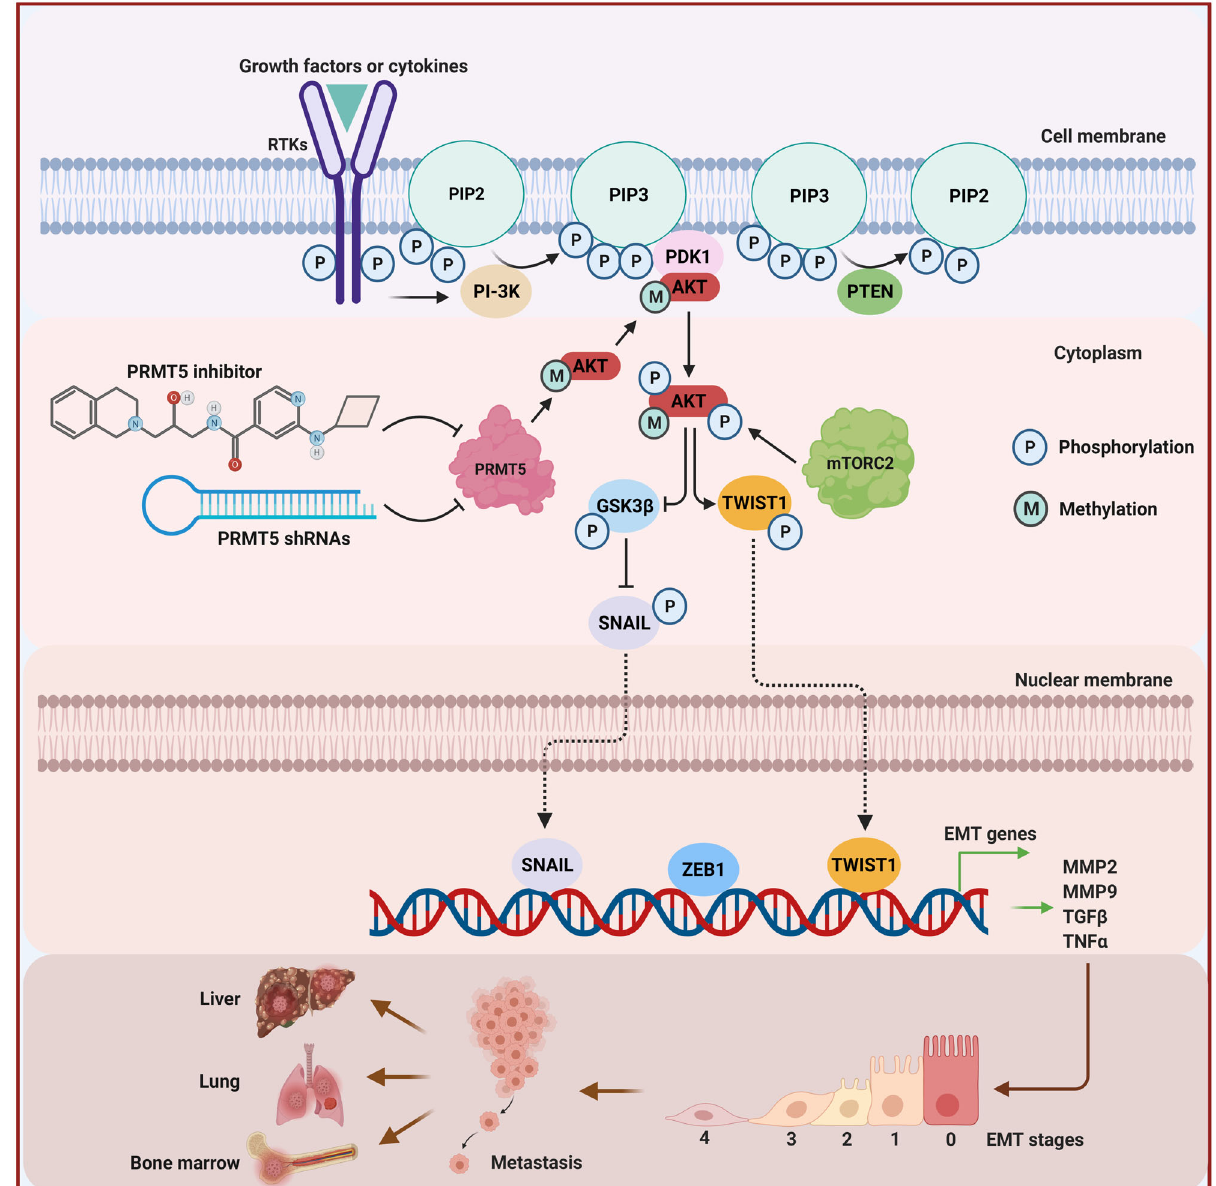
Fig. 8 Graphic summary of the mechanism by which PRMT5 regulates AKT activation to promote metastasis. AKT is activated in a cascade of events. Upstream stimuli, such as growth factors and cytokines, induce the production of phosphatidylinositol (3,4,5) trisphosphates (PIP3) by phosphoinositide 3-kinase (PI3K). These phospholipids serve as plasma membrane docking sites for AKT and PDK1 at pleckstrin-homology (PH) domains. PDK1 phosphorylates AKT at Thr308 at the plasma membrane which partially activates AKT, whereas AKT is fully activated after phosphorylation at Ser473 by mTORC2. PRMT5 methylates AKT1 on R15 in the PH domain, by which it promotes AKT1 association with the plasma membrane and subsequent phosphorylation by PDK1 and mTORC2. Downstream of AKT signaling, PRMT5 increases the expression of EMT transcription factors, such as SNAIL, ZEB1, and TWIST1 augmenting the EMT program to promote tumor